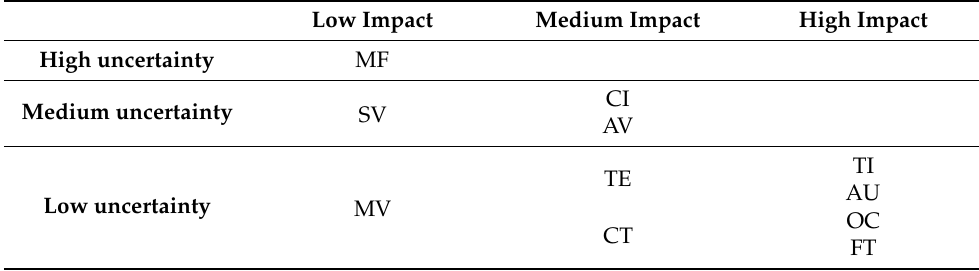
Table 4. Overall picture of complexity indicators.